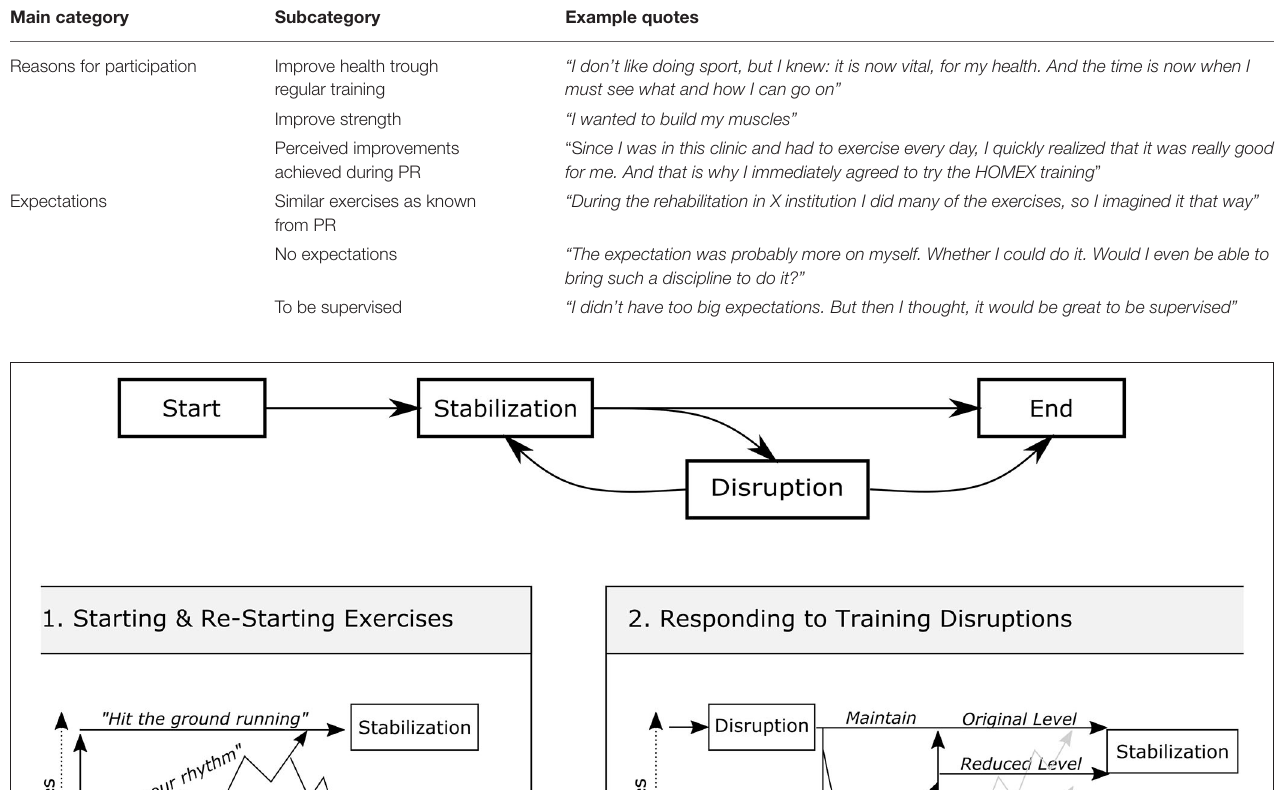
of the contextualized annual training of the participants are provided in the Supplementary Material